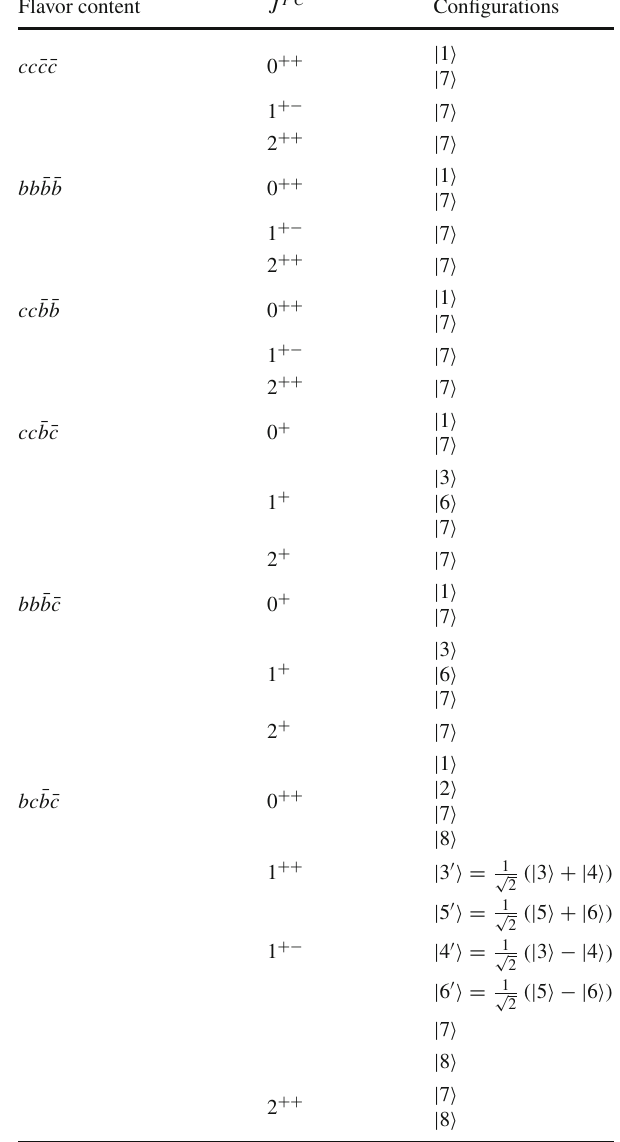
Table 1 Flavor configurations of fully-heavy tetraquark states Flavor content J PC Configurations cc ¯ c ¯